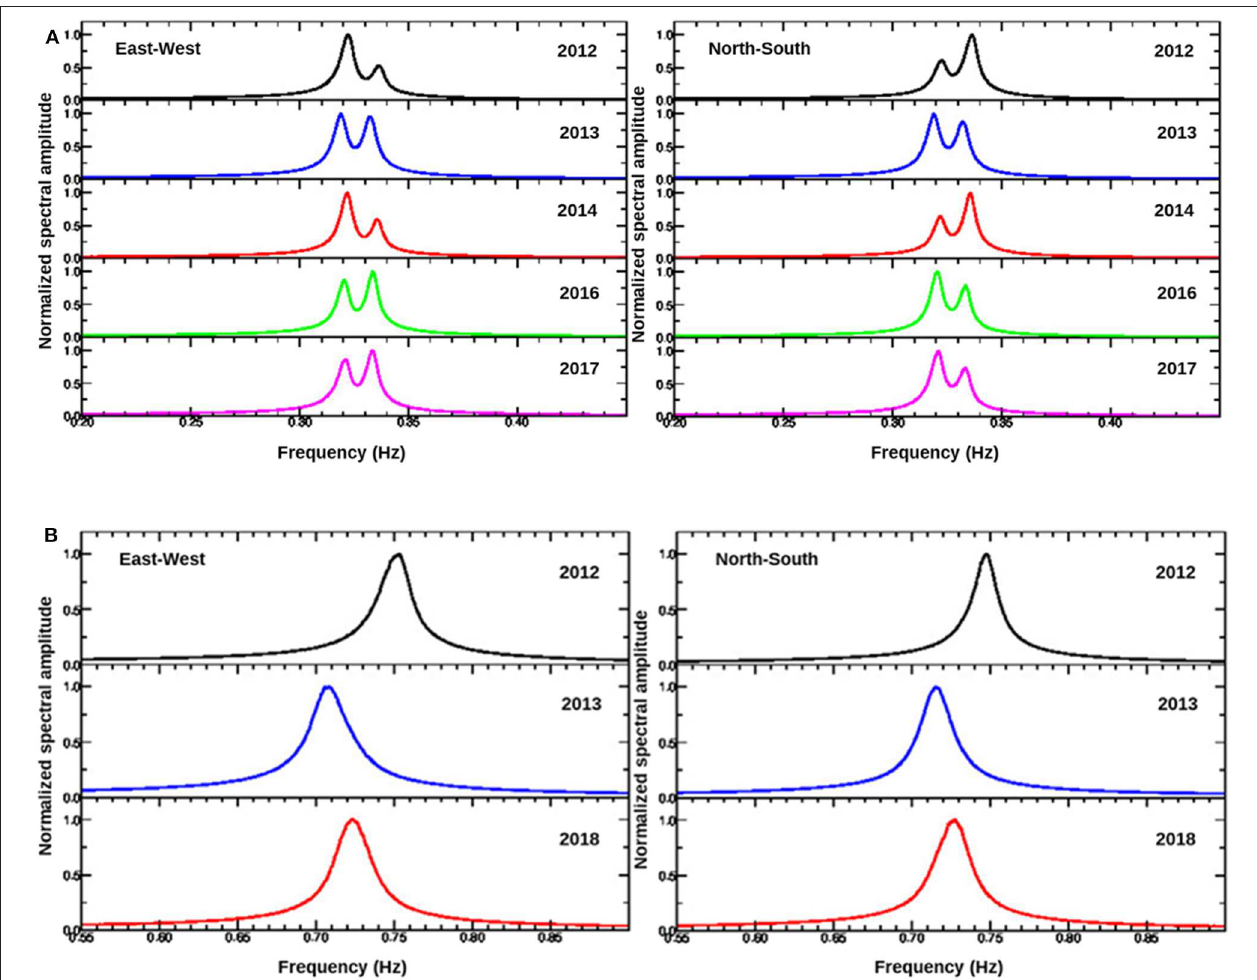
FIGURE 6 | Spectral peak corresponding to the F1 first flexural mode obtained from the data recorded in the different surveys (EW component on the left and NS on the right) for (A) Asinelli Tower and (B) Garisenda